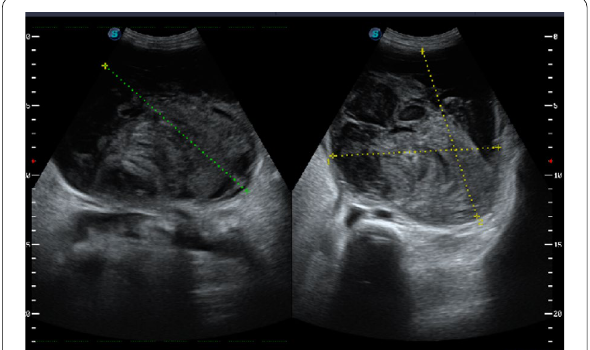
Fig. 3 Ultrasound images of a heterogeneous mass lesion measuring 11.6 12.9 13.6 cm in mid abdomen extending into lower × × abdomen